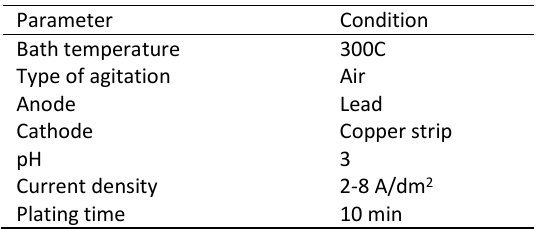
Plating parameters for varying current density in nickel- chromium plating at constant plating time.